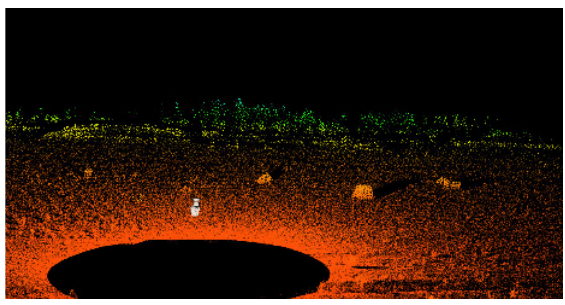
Figure 9: Dust removed leaving only ground and above ground objects.